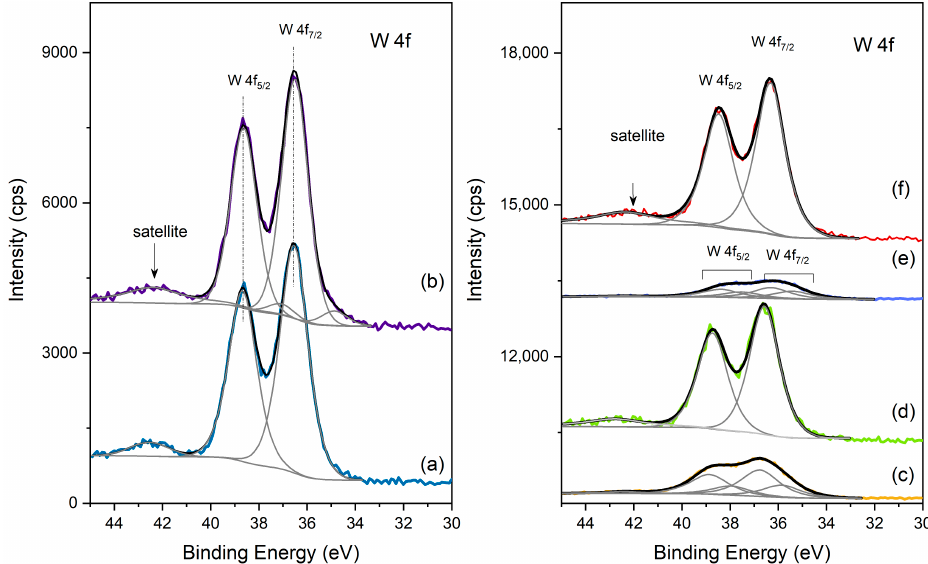
Figure 5. XPS spectra of the different catalysts in the W 4f region: (left) ( a ) HPW; ( b ) Cs 2.5 salt; (right) ( c ) HPW/Pt-Al 2 O 3 ; ( d ) Pt-Al 2 O 3 /Cs 2.5 ; ( e ) HPW/Ni-Al 2 O 3 ; ( f ) Ni-Al 2 O 3 /Cs 2.5 .